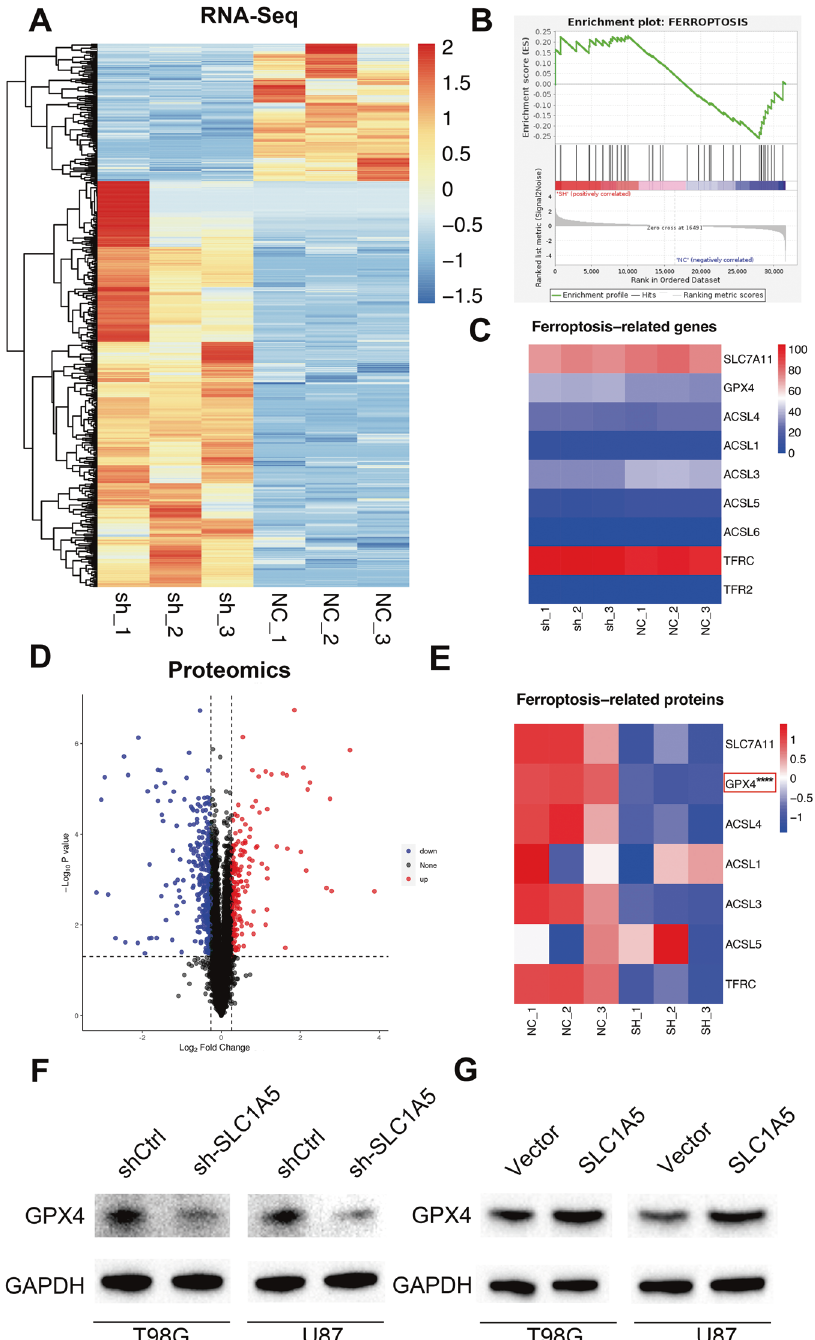
Fig. 6 Integrated proteotranscriptomics analysis revealed that SLC1A5 regulated ferroptosis state by affecting the expression of GPX4. A The differentially expressed genes between shCtrl and sh-SLC1A5 groups through RNA-sequence. B GSEA analysis showed the correlation between the differentially expressed genes and ferroptosis pathway. C The mRNA expression of ferroptosis-related genes in the shCtrl and sh- SLC1A5 group. D The differentially expressed proteins between shCtrl and sh-SLC1A5 group through TMT-proteomics analysis. E The expression of ferroptosis-related proteins in the shCtrl and sh-SLC1A5 group. The Western Blot indicating the expression of GPX4 in T98G and U87 cell lines after SLC1A5 knockdown ( F ) or overexpression ( G ) by Western Blot.